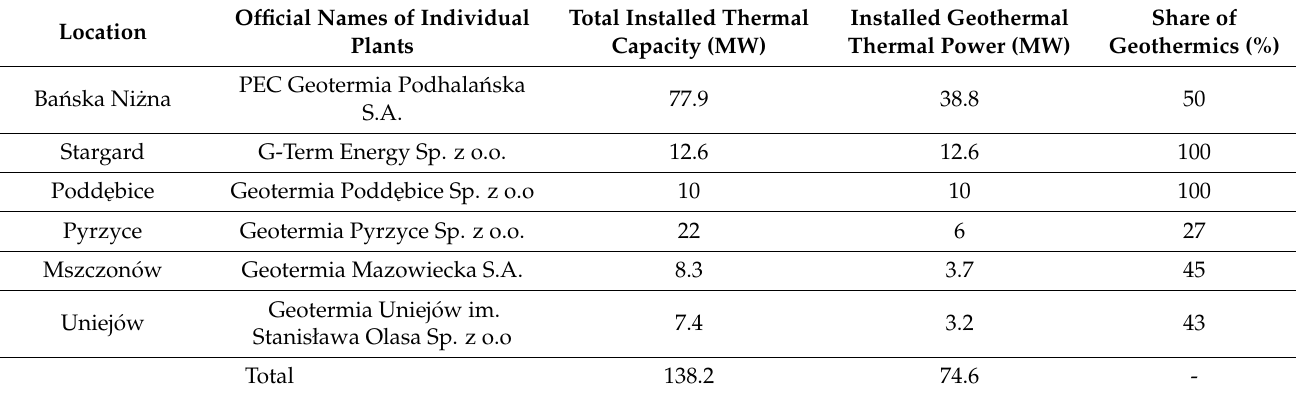
Table 1. The largest thermal power stations in Poland,